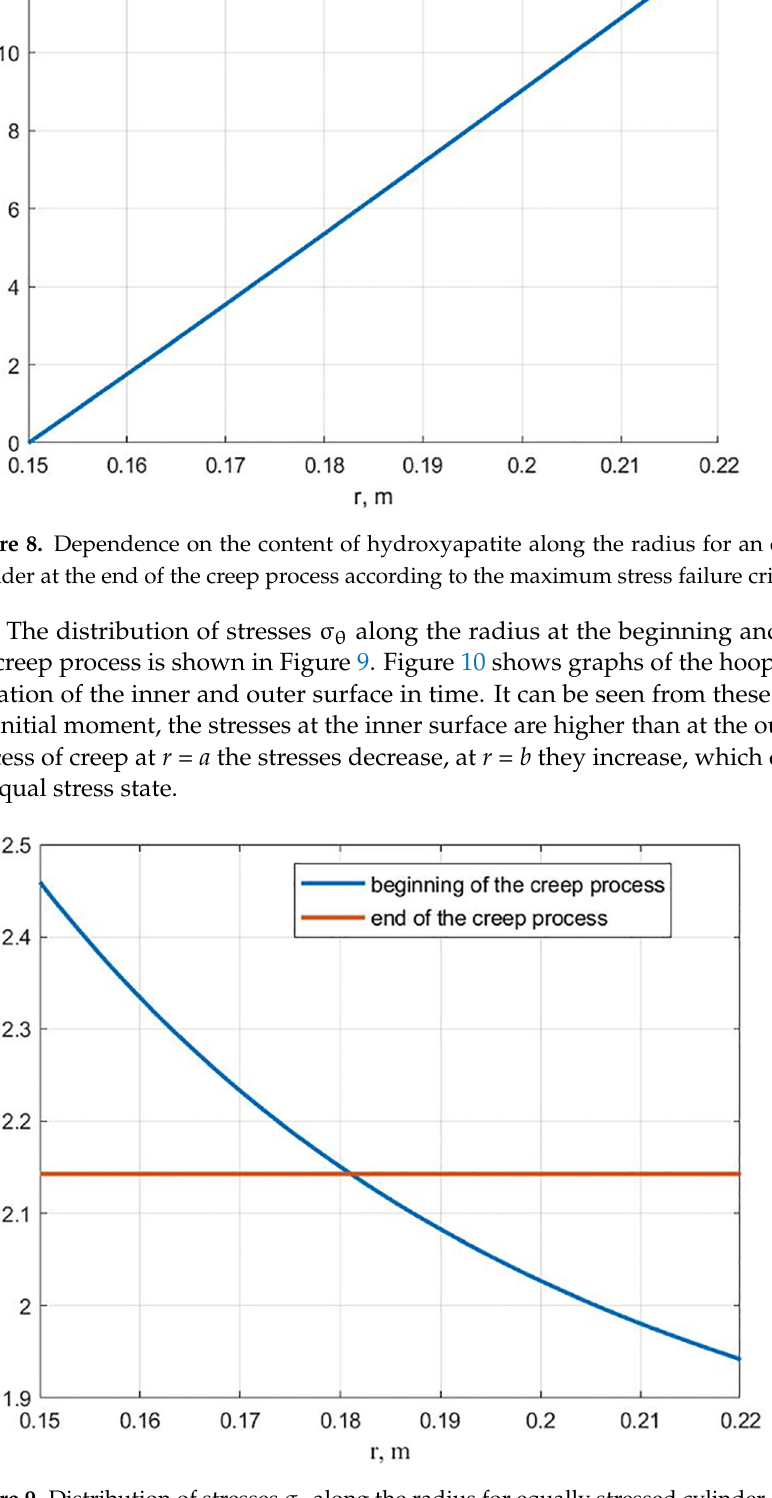
Figure 9. Distribution of stresses σ θ along the radius for equally stressed cylinder at the end of the creep